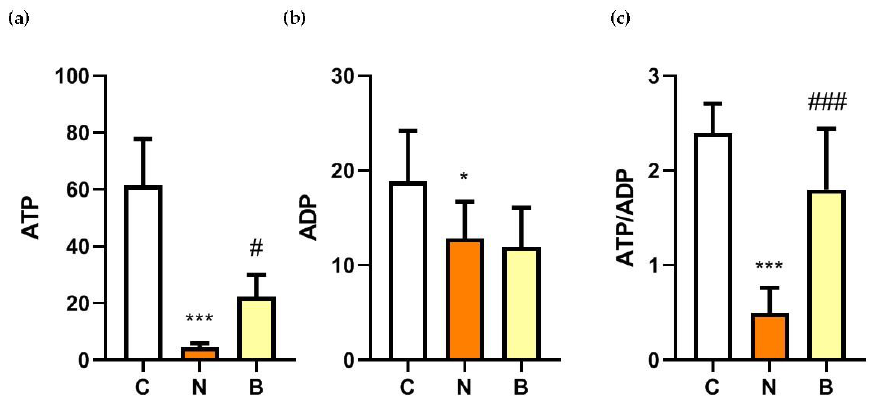
Figure 3. Effect of β -hydroxybutyrate on glucose-deprivation-induced changes in ATP and ADP concentrations, and ADP/ATP ratios. Neuro-2a cells were cultured in the glucose-containing basal condition (C group), or in the condition of glucose deprivation with (B group) or without the presence of 10 mM β -hydroxybutyrate (N group) for 24 h. Changes in ( a ) adenosine triphosphate (ATP) and ( b ) adenosine diphosphate (ADP) concentrations, and ( c ) the ratios of ATP to ADP are shown. Data are means ± SEM of 4–6 independent experiments, each with three replicates. Statistical analysis was performed with one-way ANOVA followed by a Tukey’s HSD post hoc test. *, p < 0.05; ***, p < 0.001 compared with the control group. #, p < 0.05; ###, p < 0.001 compared with the N group.